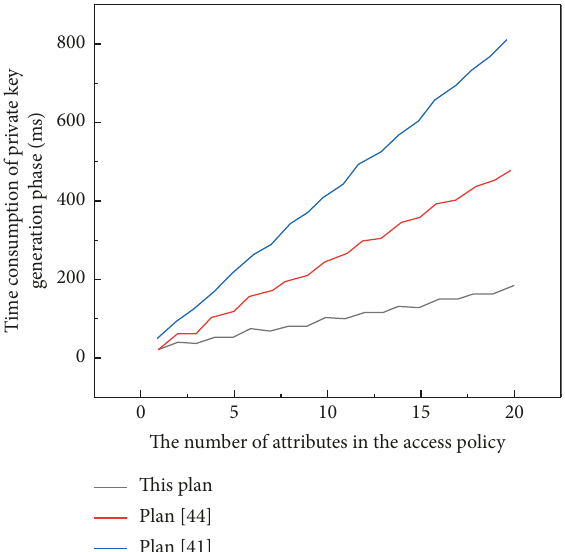
Figure 3: Time consumption of private key generation algorithm.